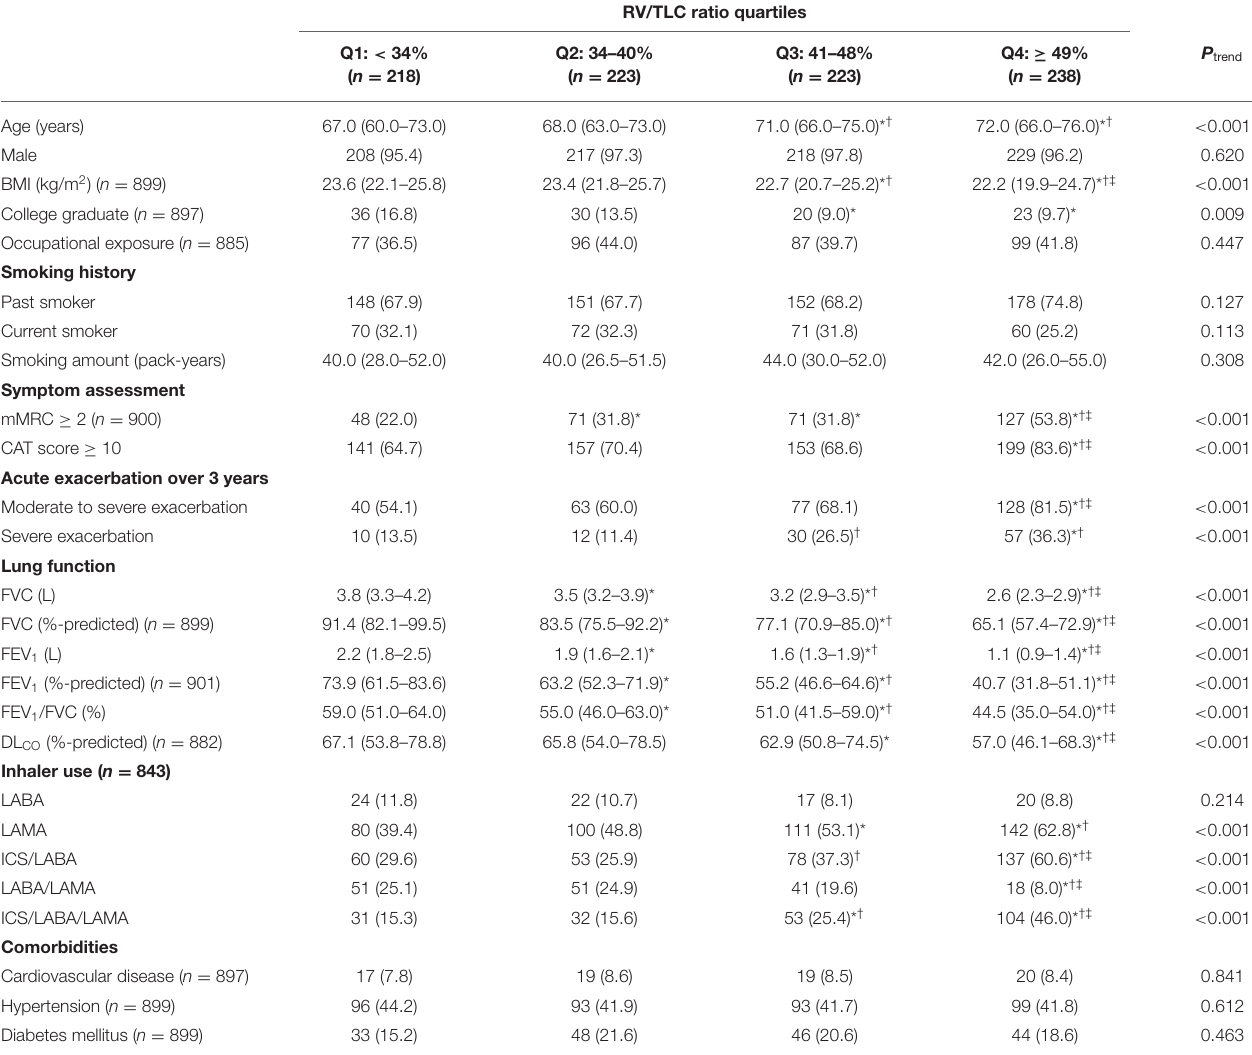
TABLE 1 | Baseline characteristics of the study